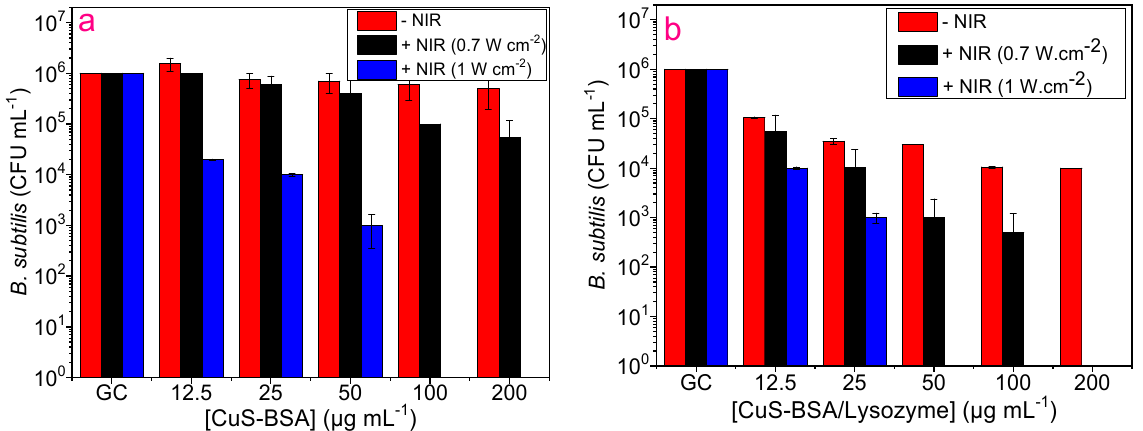
Figure 7. Antibacterial activity of ( a ) CuS-BSA and ( b ) CuS-BSA/lysozyme on B. subtilis using various concentrations with and without NIR irradiation (980 nm, 3 min).